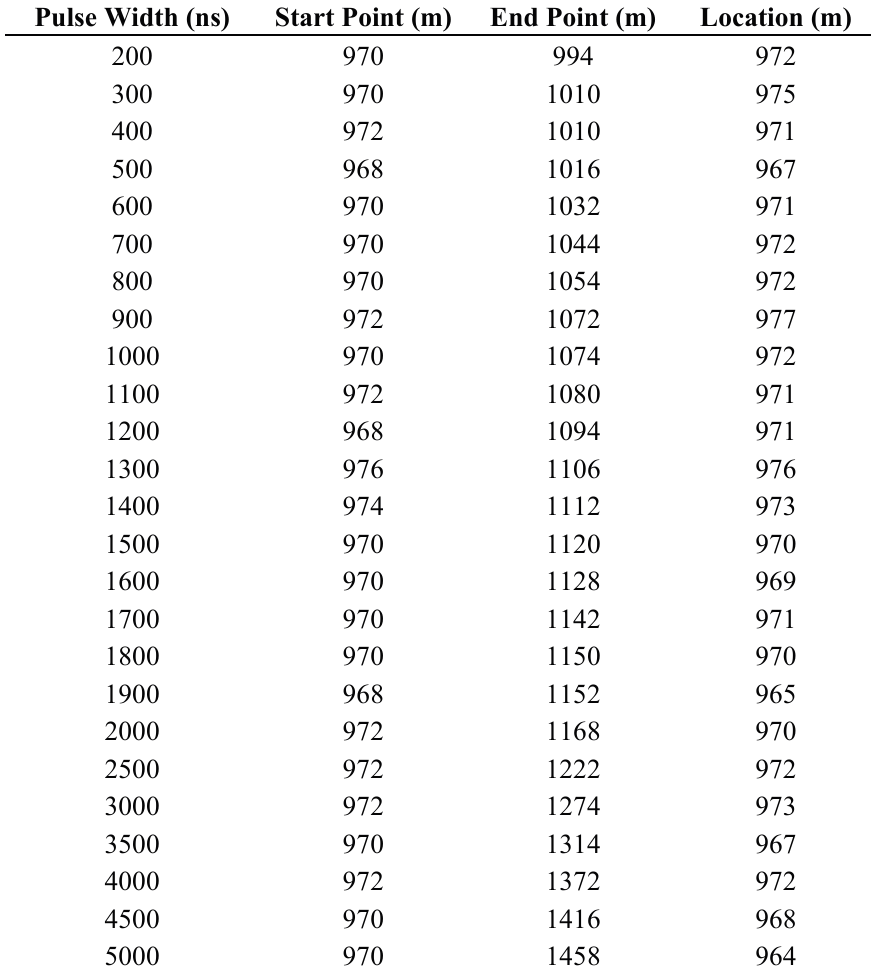
Figure 7. Locating results under different pulse widths. Table 2. Locating results under different pulse